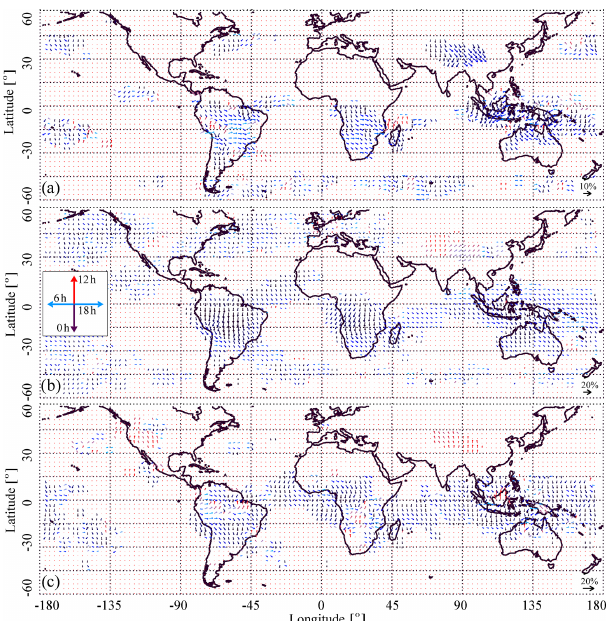
Figure 5. Diurnal variation of (a) high opaque clouds, (b) cirrus clouds, and (c) thin cirrus clouds estimated from AIRS/IASI for January. Statistics is averaged over the period of 2008–2015. Vec- tor length is proportional to the amplitude and its orientation de- fines the local time of the peak: downwards for 00:00LT, left for 06:00LT, upwards for 12:00LT, and right for 18:00LT. For the sake of readability, the arrows are also coloured in tints of red for day (06:00–18:00LT) and in shades of blue for night